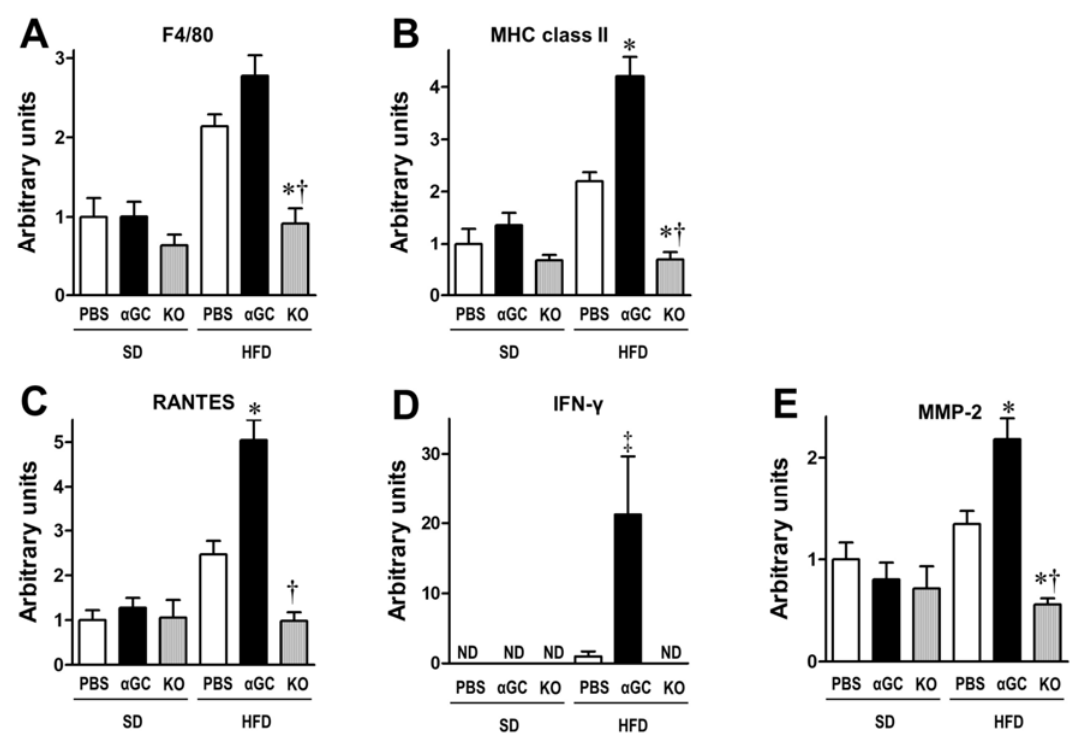
Figure 3. Gene expression of F4/80 ( A ), major histocompatibility complex (MHC) class II ( B ), regulated upon activation normal T cell expressed secretion (RANTES; ( C )), interferon (IFN)- γ ( D ), and matrix metalloproteinase (MMP)-2 ( E ) in aortic tissues from six groups of SD-PBS (n = 6), SD- α GC (n = 7), SD-KO (n = 3), HFD-PBS (n = 21), HFD- α GC (n = 21), and HFD-KO (n = 9) mice. * p < 0.05 vs. HFD-PBS, † p < 0.01 vs. HFD- α GC by ANOVA, and ‡ p < 0.05 vs. HFD-PBS by student t test. All data are expressed as means ± S.E. ND, not detected.